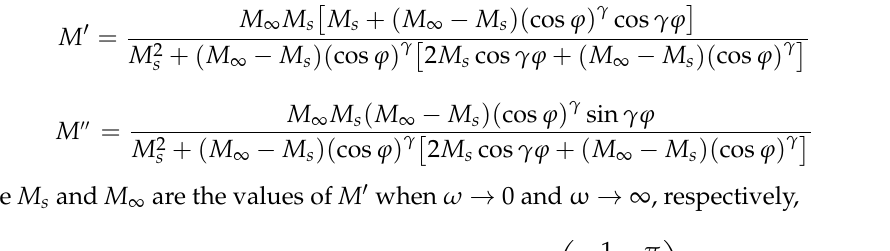
proximating curves according to the Cole–Davidson model.